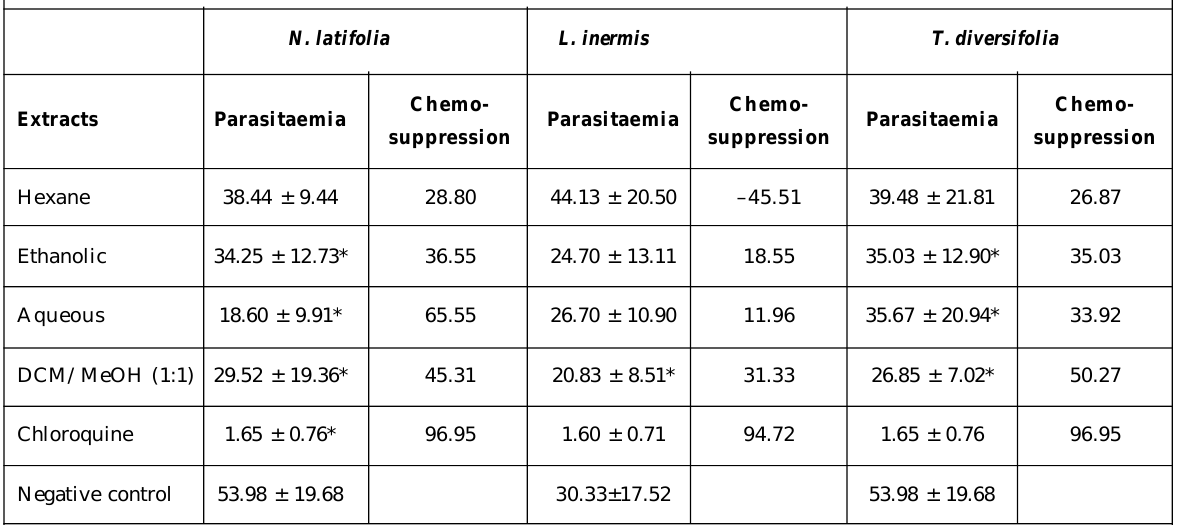
Table 3: In vivo suppressive antimalarial screening of Tithonia diversifolia, Lawsonia inermis and Nauclea latifolia at 250 mg/kg against Plasmodium berghei infected mice at day 6